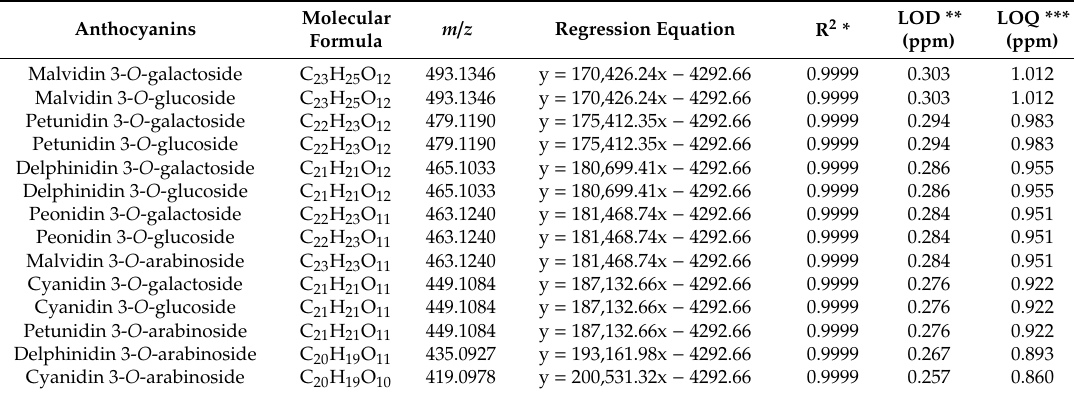
Table 2. Mass information and regression equation data of the 14 anthocyanins identified in blueberry extracts. Molecular m / Anthocyanins Formula